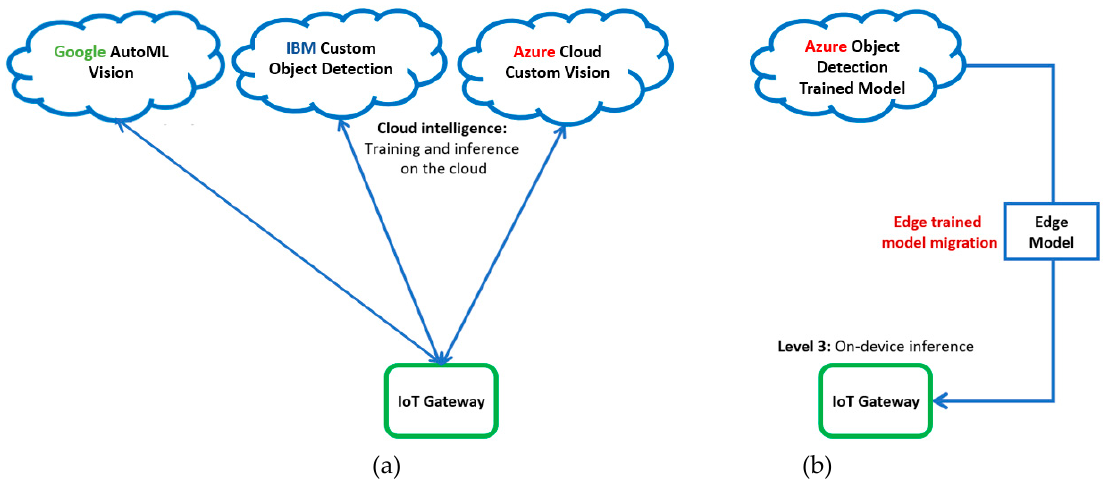
Figure 12. Communication edge cloud. ( a ) Training and inference in the cloud; ( b ) training in the cloud, inference in the edge.